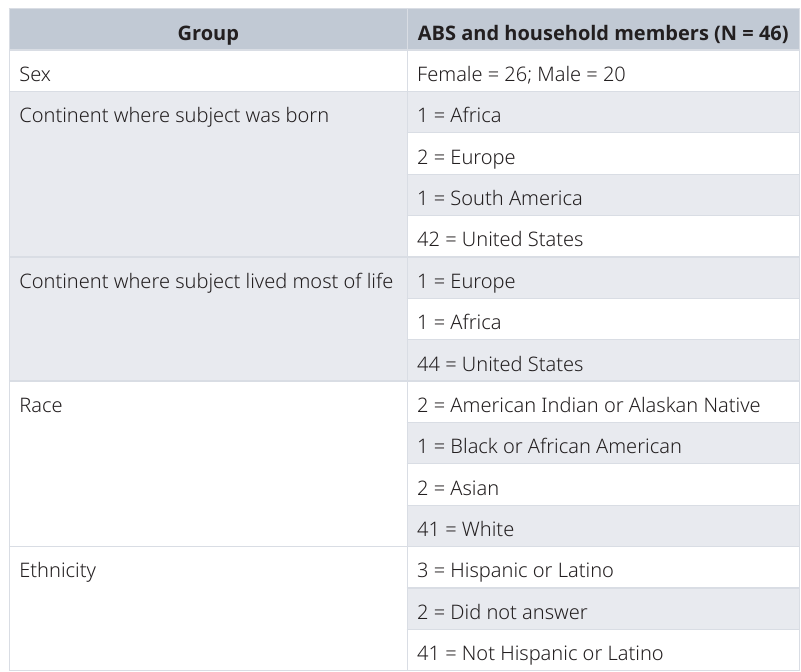
Table 1. Demographics of